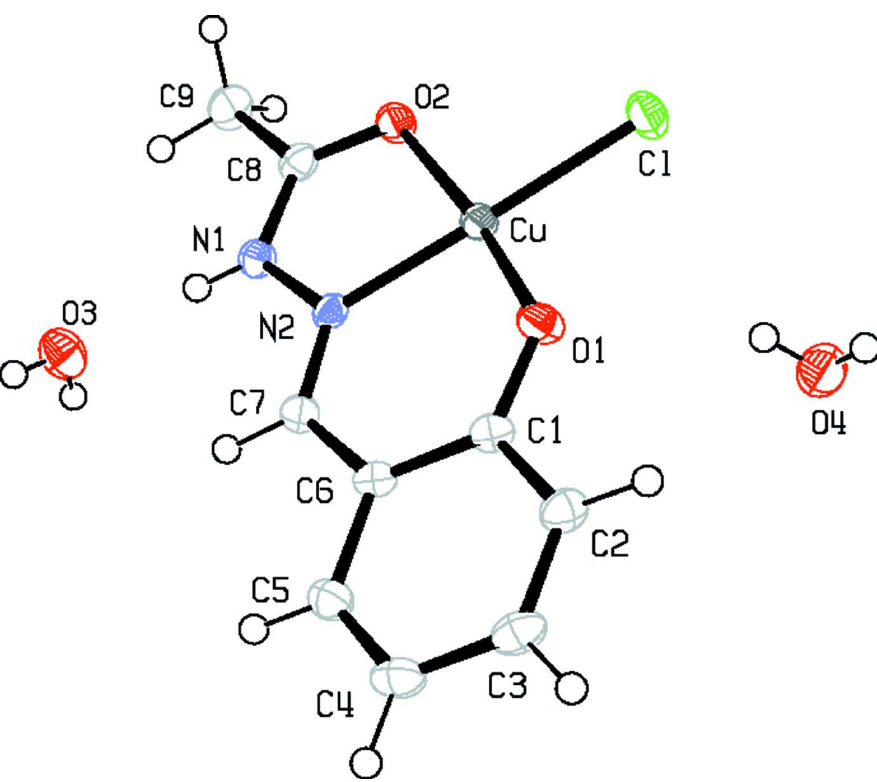
Figure 1 A view of the molecular structure of compound (I), showing the atom-numbering scheme. Displacement ellipsoids are drawn at the 50% probability